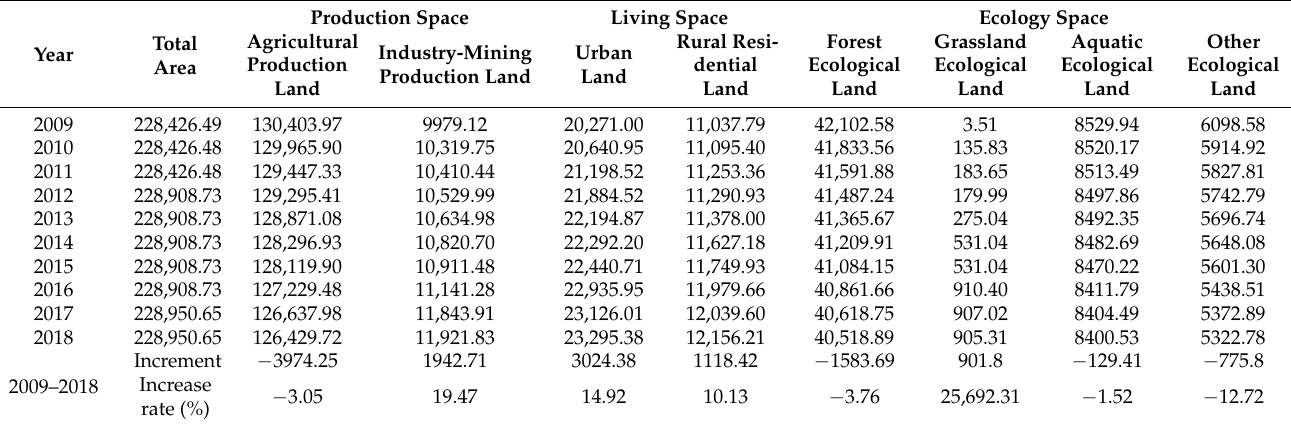
Table 3. The area (in ha) of “production-living-ecological” spaces in Haikou from 2009 to 2018. Production Total Year Area